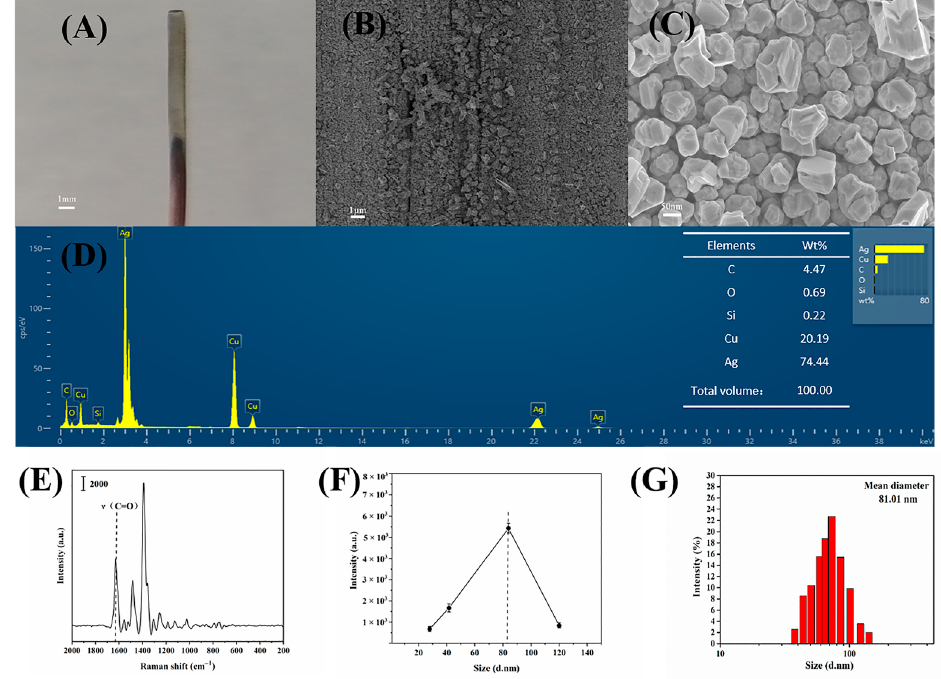
Figure 2. ( A ) Surface appearance of copper rod coated with Ag NPs layer. ( B ) Surface appearance of Ag NPs layer. ( C ) Morphology of Ag NPs. ( D ) Energy-dispersive X-ray (EDX) spectra of Ag NPs. ( E ) SERS spectra of silver films as a substrate for detection of ENRO. ( F ) Effect of particle size on SERS effect. ( G ) The particle size distribution of Ag NPs.